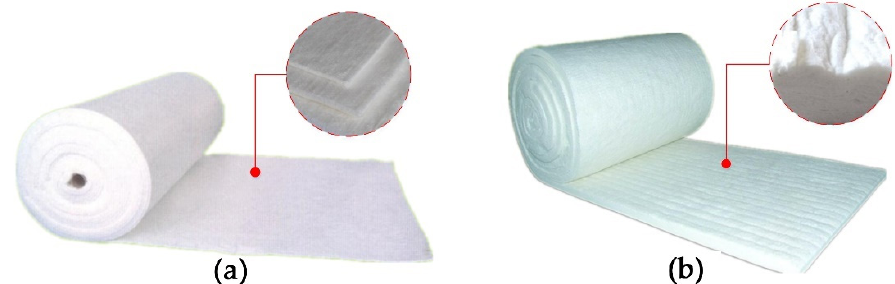
Figure 8. Fire-retardant materials. ( a ) High-silica needled felt, ( b ) ceramic fiber felt. Figure 8. Fire ‐ retardant materials. ( a ) High ‐ silica needled felt, ( b ) ceramic fiber felt.